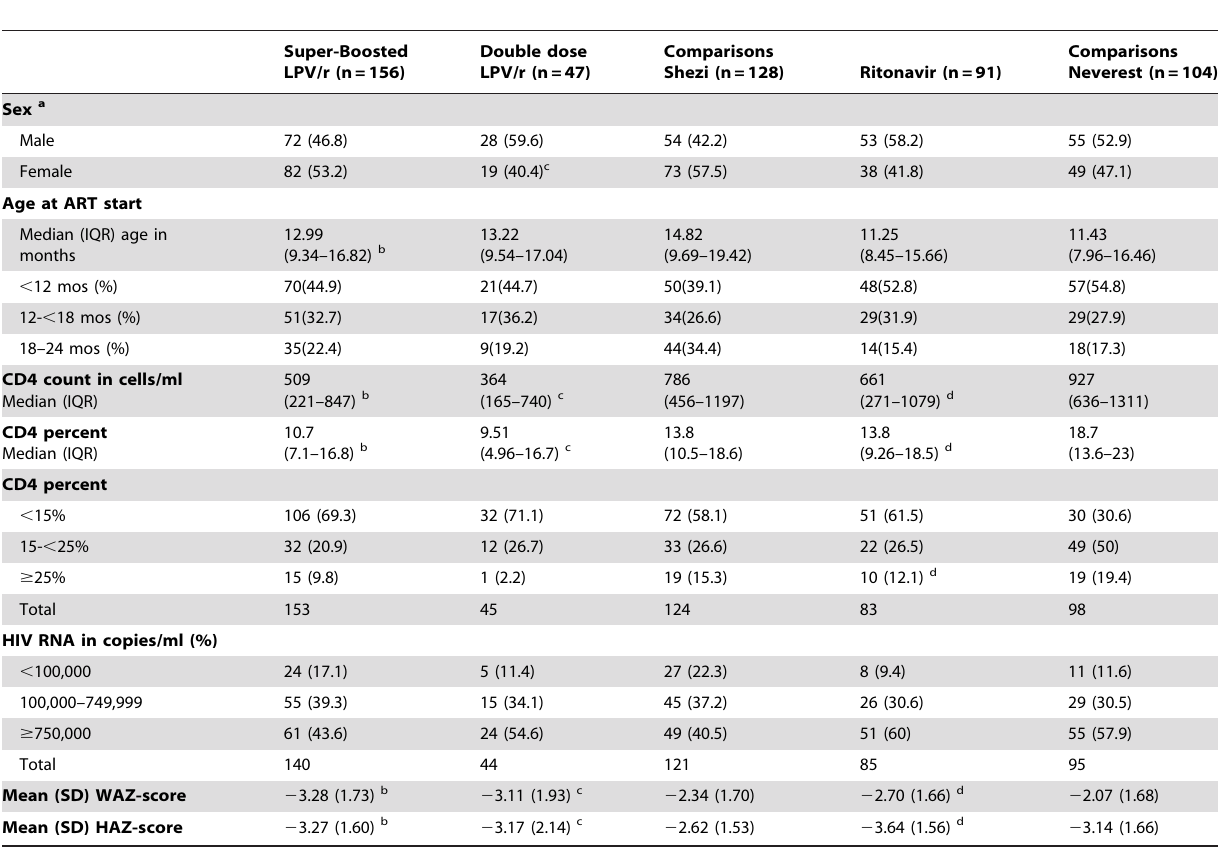
Table 2. Pre-antiretroviral treatment (ART) characteristics stratified by the modification made to the ART regimen among 294 children treated for TB and 232 comparison children not treated for TB at each